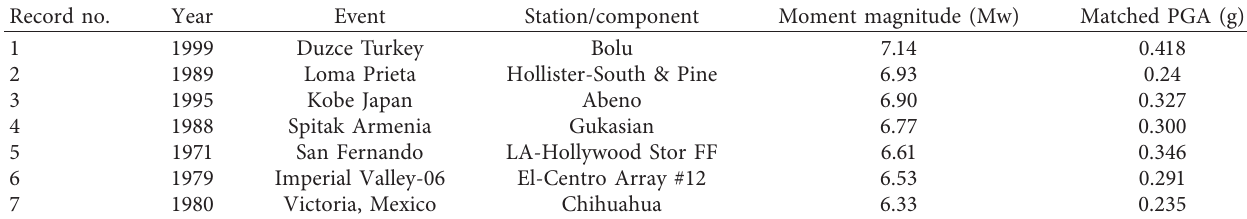
Table 1: Details of selected acceleration time histories for incremental dynamic analysis. Record